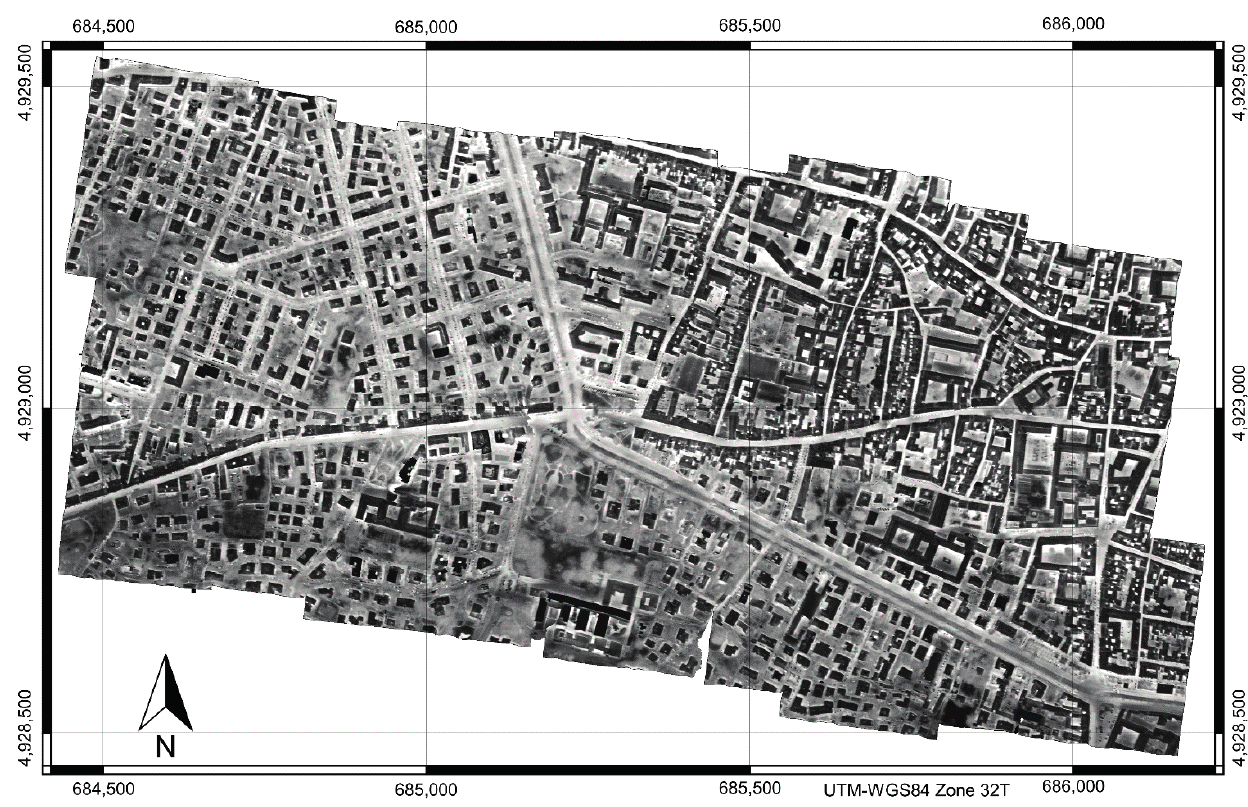
Figure 2. Orthophoto-mosaic of 30 thermal images acquired over the test area in Bologna. A rigorous parameterization of the model requires measured vertical profiles of the air temperature, pressure and humidity and the volume mixing ratio of each molecular species composing the atmosphere. Of course, such detailed knowledge is normally unavailable. For the present study, however, three different parameterization of the Modtran model were tested and compared. The first run used the profiles obtained by a daily radiosonde launched at 00:00 UTC from the station of the Regional Agency for Environmental Protection (ARPA) at San Pietro Capofiume, located about 30 km NE of Bologna. It provides vertical profiles of temperature, pressure, relative humidity and wind speed from the ground to an altitude of about 20 km. The second run used instead the profiles obtained by a MODIS Terra second level product [18], based on an image acquired at 20:30 UTC, about one hour later than the thermal flight. MODIS data contain also information about the total precipitable water vapor and the total ozone burden in the air column. Finally, the third run of the model simply used the mid-latitude winter (MLW) pre-defined profile, which would be the most appropriate choice, if no other data were available. A comparison between the vertical profiles of air temperature used in the three Modtran runs is shown in Figure